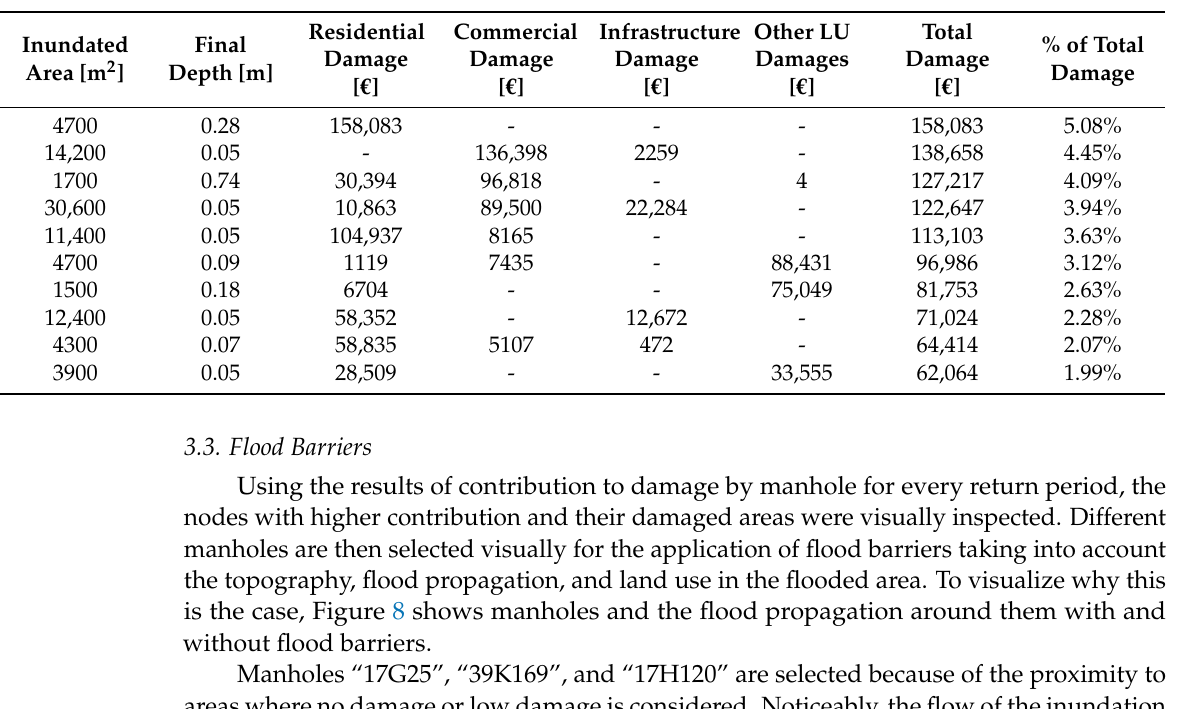
Table 1. Flood extent and damage by manhole contribution and land use.